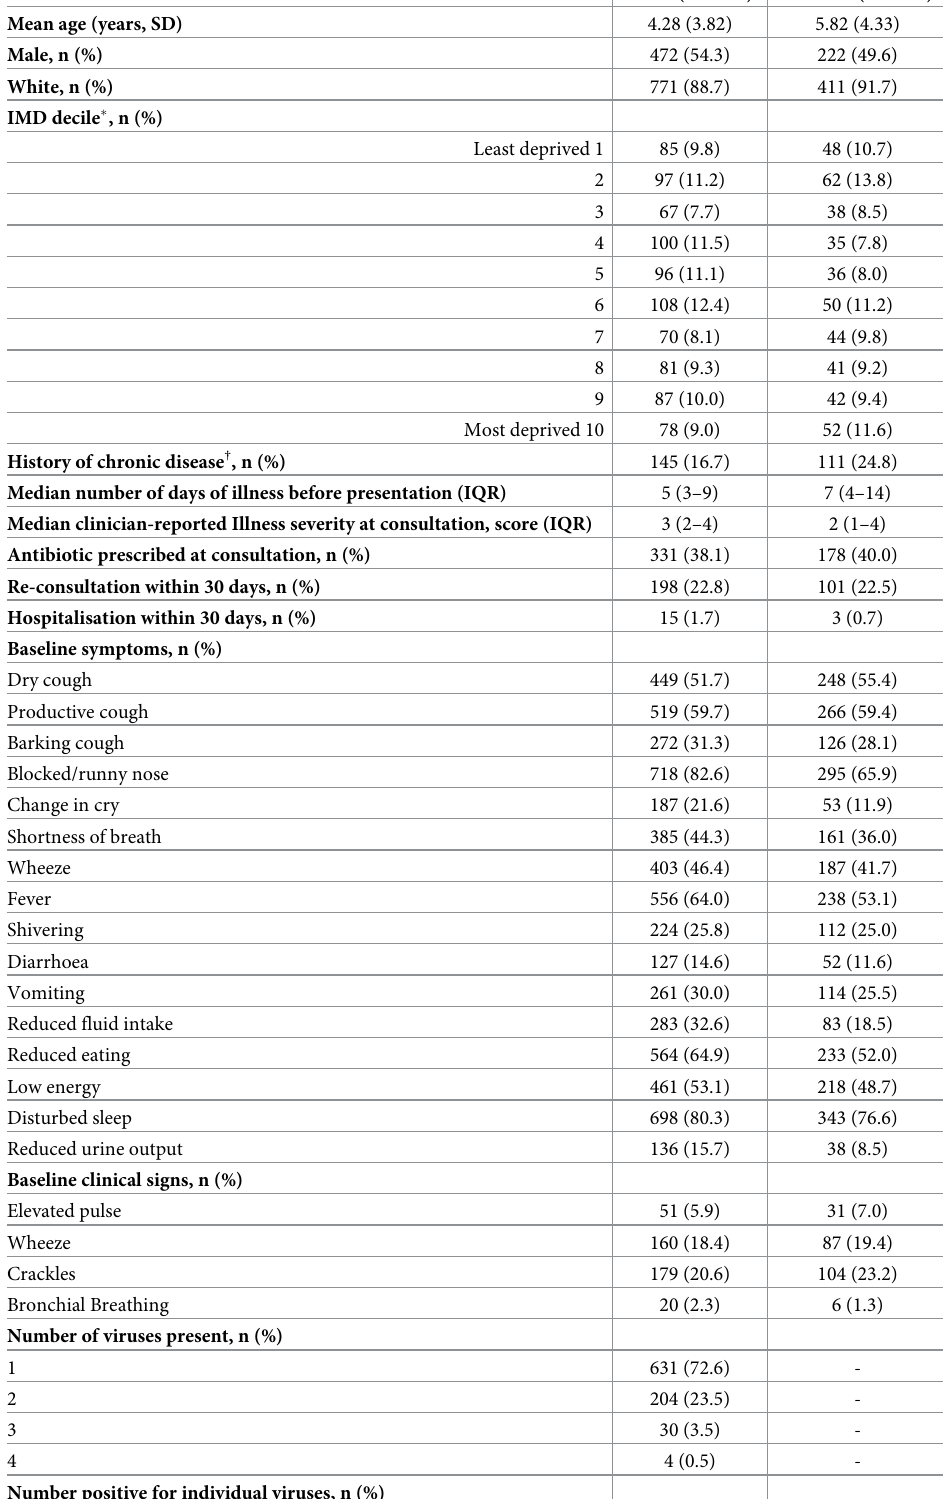
Table 1. Baseline characteristics of children stratified by the presence of any virus detected a